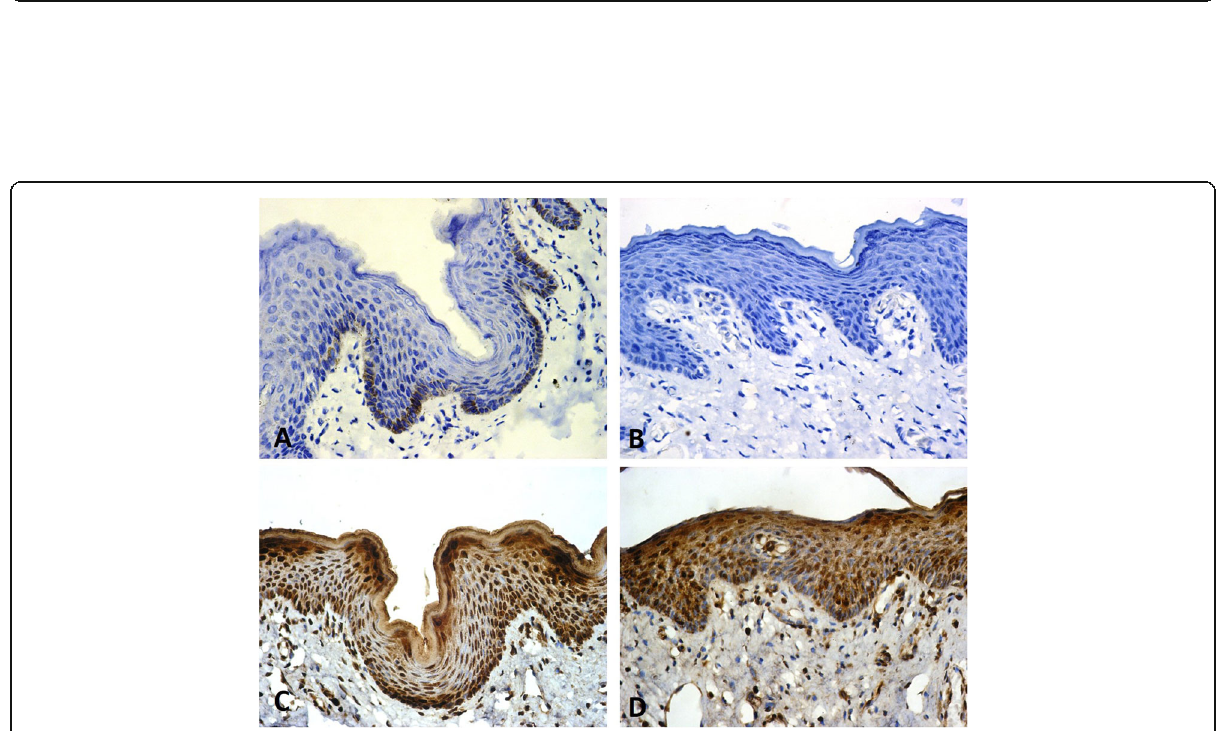
Fig. 4 Histo-patholological evaluation of genital skin biopsies: immune-staining for commercially available ready to use mouse monoclonal antibody against Estrogen Receptor (ER) α and β . Upper row ( a and b ): Hormonally treated group ( a ) showed weak ER α expression (+) that was localized to the stratum basale, in contrast to the ‘ untreated ’ group ( b ) that showed no detectable expression (0). (original magnification × 400). Lower row ( c and d ): ER β immunoreactivity was strongly expressed in the keratinocytes of the stratum basale and stratum spinosum (+++) in the treated group ( c ); while in untreated group ( d ), there was moderate expression (++). (A&B: ER β , immunoperoxidase; original magnification ×